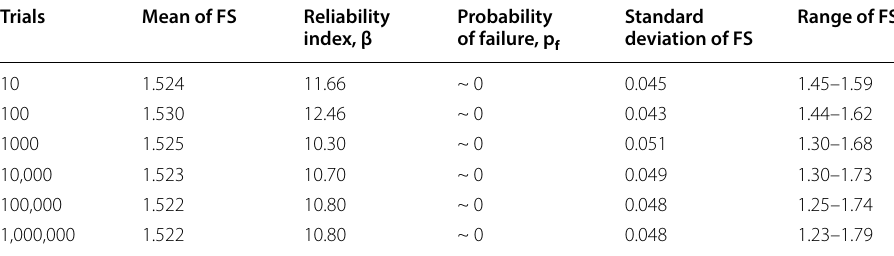
Table 9 Statistical moments of MCS results in LEA analysis